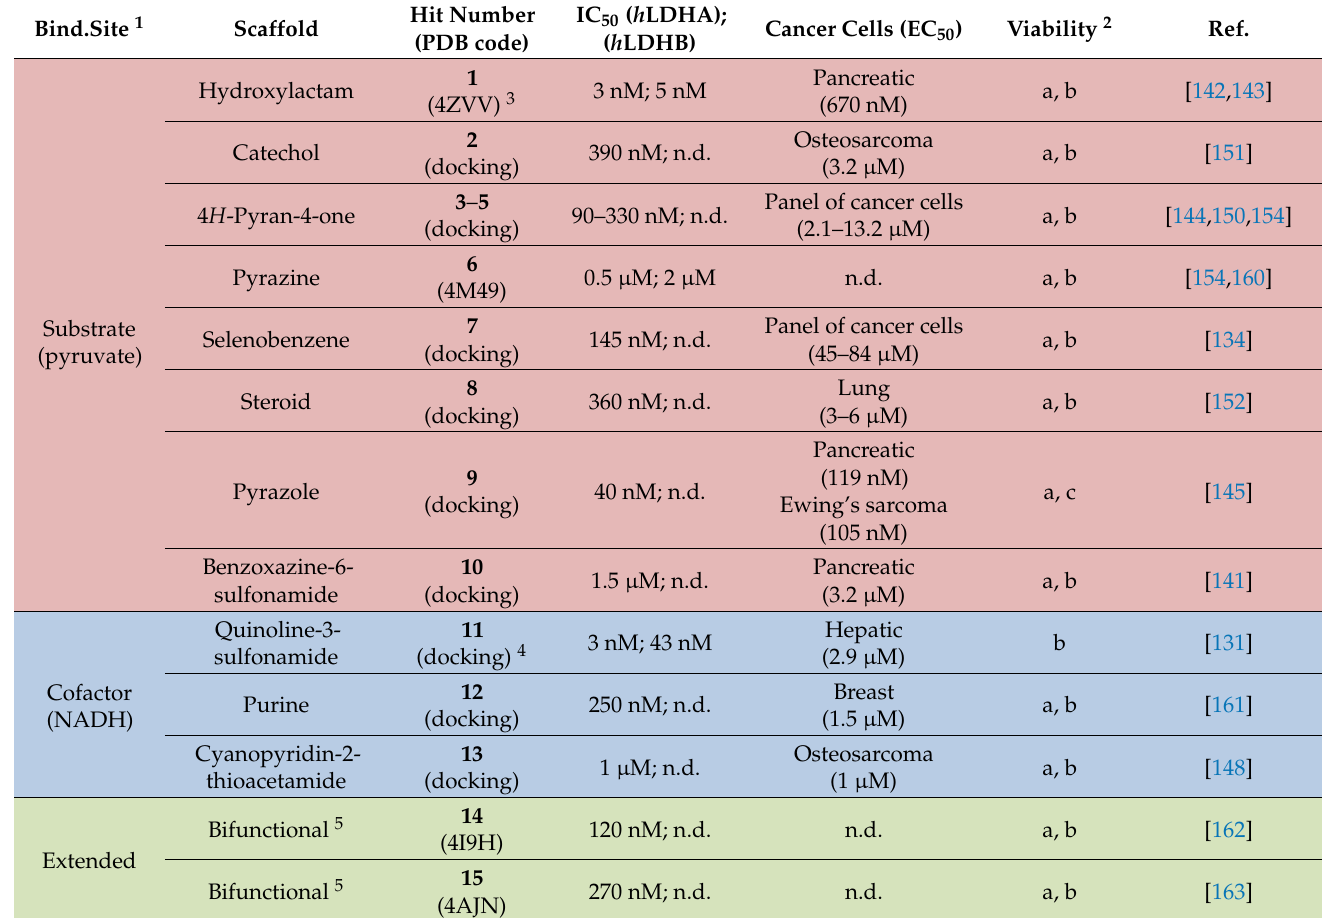
Table 1. Activity and viability of the most active hLDHA